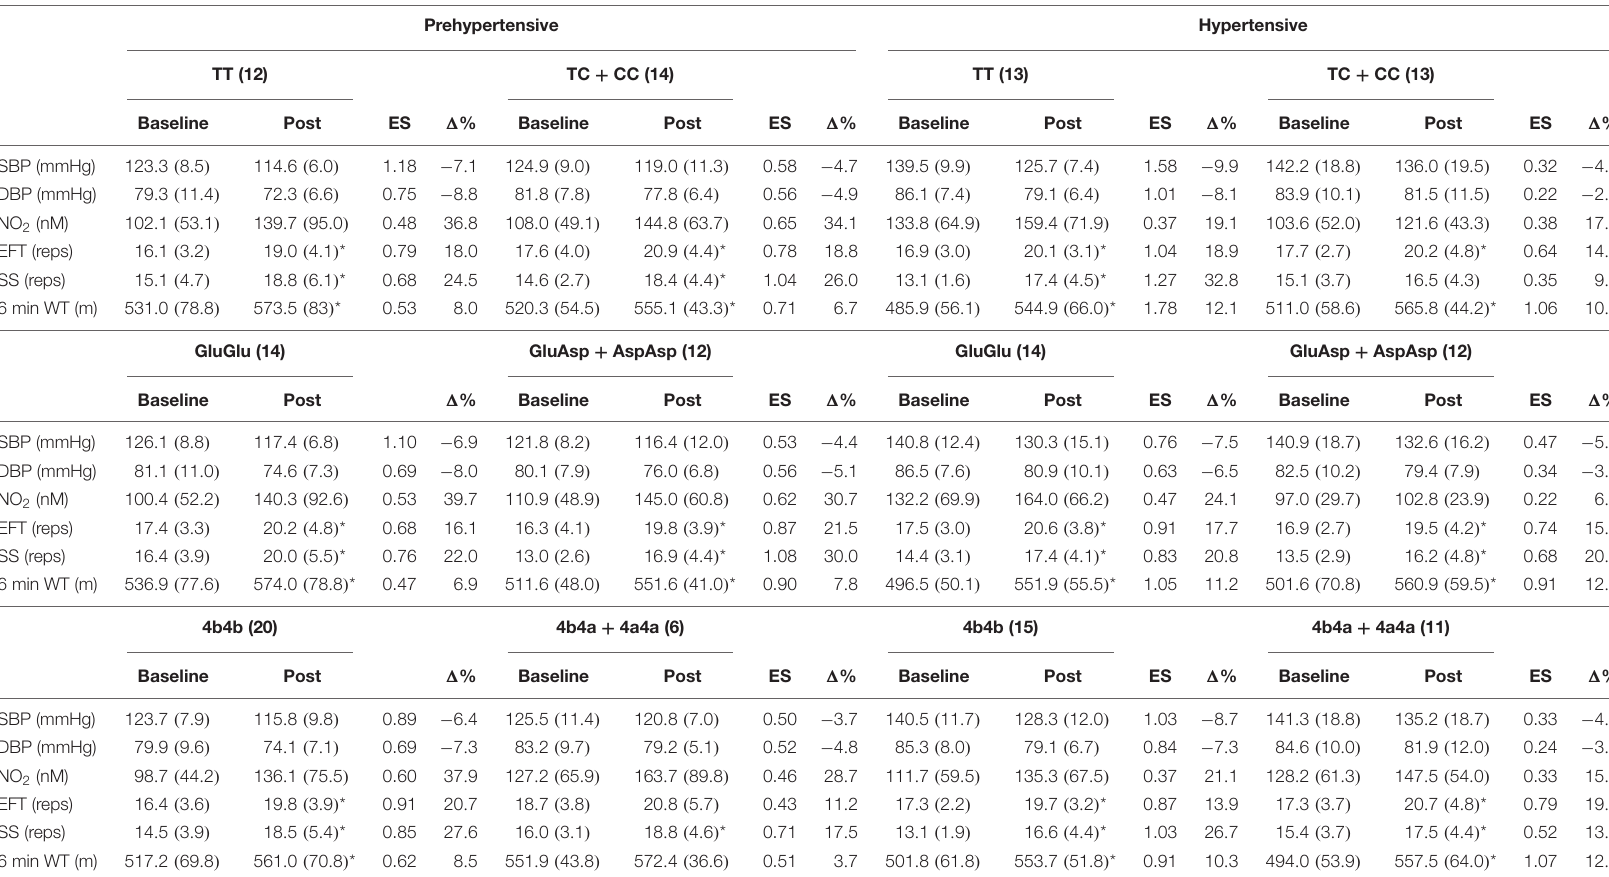
Data are reported as means (SD) baseline and post 12 weeks of multicomponent training for 52 women. Participants are divided into prehypertensive and hypertensive groups. ES, effect size; EFT, elbow flexion test; SS, sit and stand up test; 6 min WT, 6-min walk test. *p < 0.05 compared with baseline (the same group). Linear mixed-effects